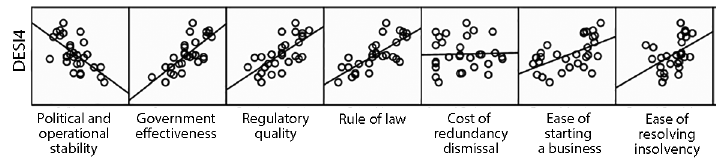
Figure 2. The relationship between the DESI4 and the 7 sub-pillars of the Institutions pillar